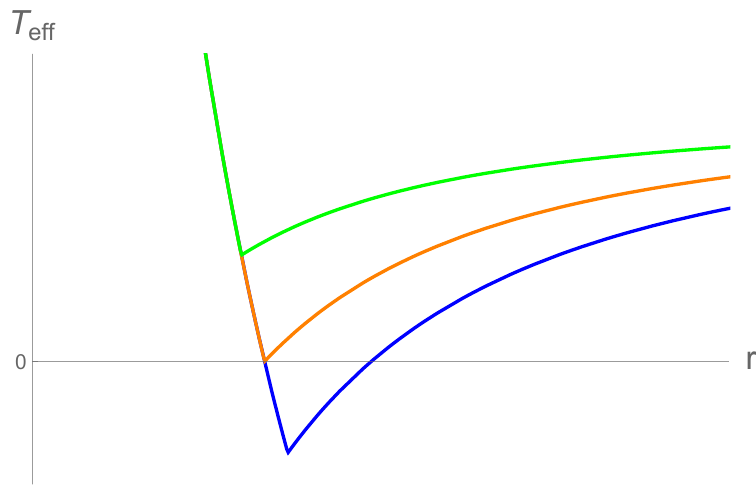
Figure 1 . Effective tension as a function of the radius. The kink occurs at the corresponding junction position. Green, top: r i < r max ( r e > r i ). Orange, middle: r i = r max ( r e = r i ). Blue, bottom: r i > r max ( r i < r e